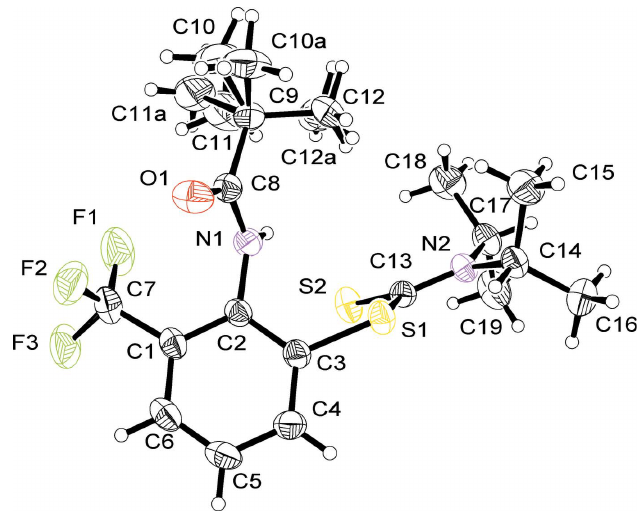
Figure 1 The molecular structure, with displacement ellipsoids at the 50% probability level, showing both orientations of the disordered tert -butyl